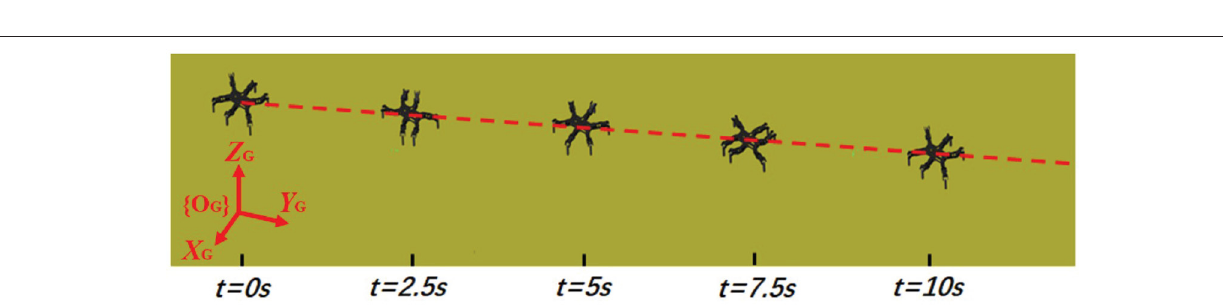
FIGURE 7 | The network architecture of the proposed DDPG-based RL.